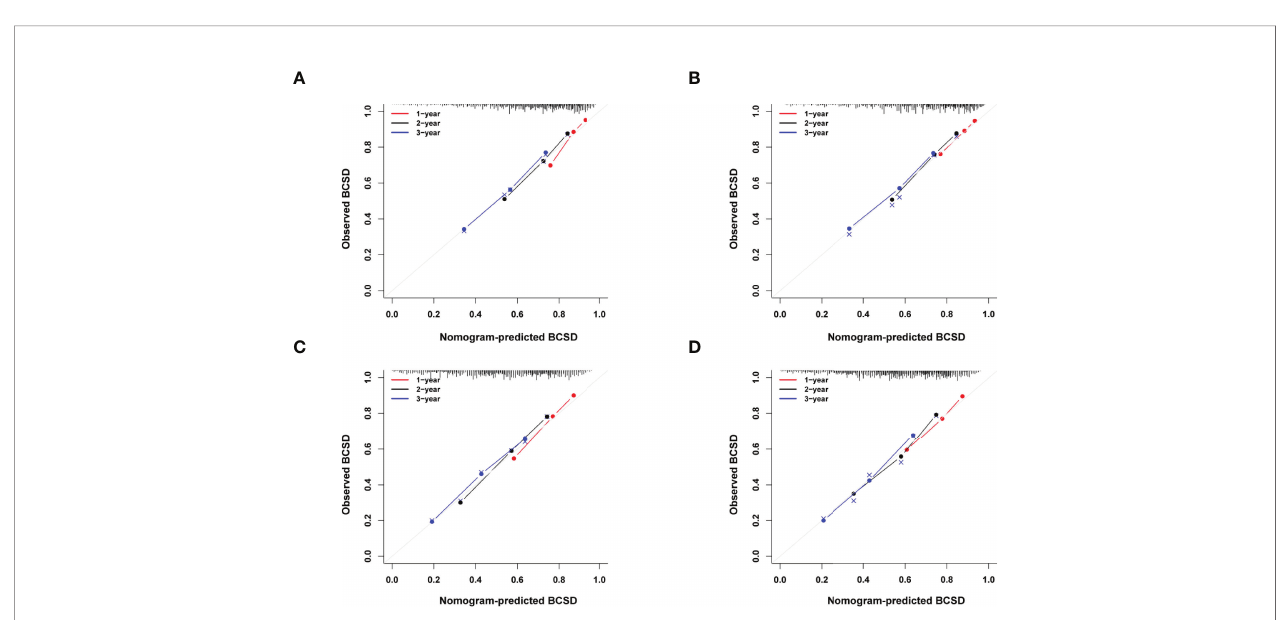
FIGURE 5 | (A) Calibration curves for predicting BCSD at 1-, 2- and 3-year intervals in the training set in bone-only metastatic pattern. (B) Calibration curves for predicting BCSD at 1-,2-and 3-year intervals in the validation set in bone-only metastatic pattern. (C) Calibration curves for predicting BCSD at 1-, 2- and 3-year intervals in the training set in viscera metastatic pattern. (D) Calibration curves for predicting BCSD at 1-, 2- and 3-year intervals in the validation set in viscera metastatic